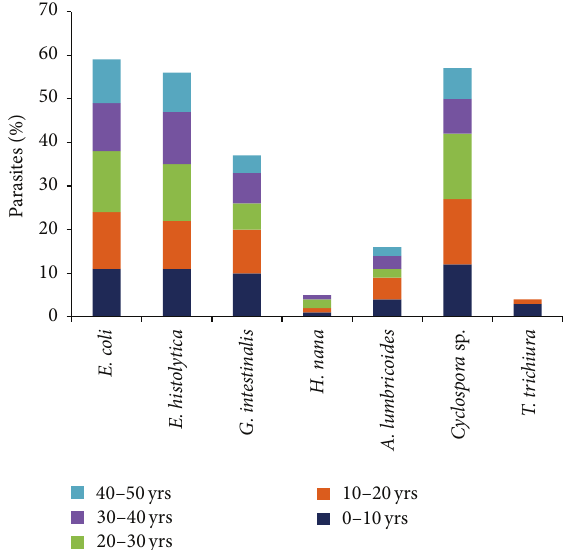
Figure 4: Distribution of parasites among different age groups from low socioeconomic areas from south Chennai.